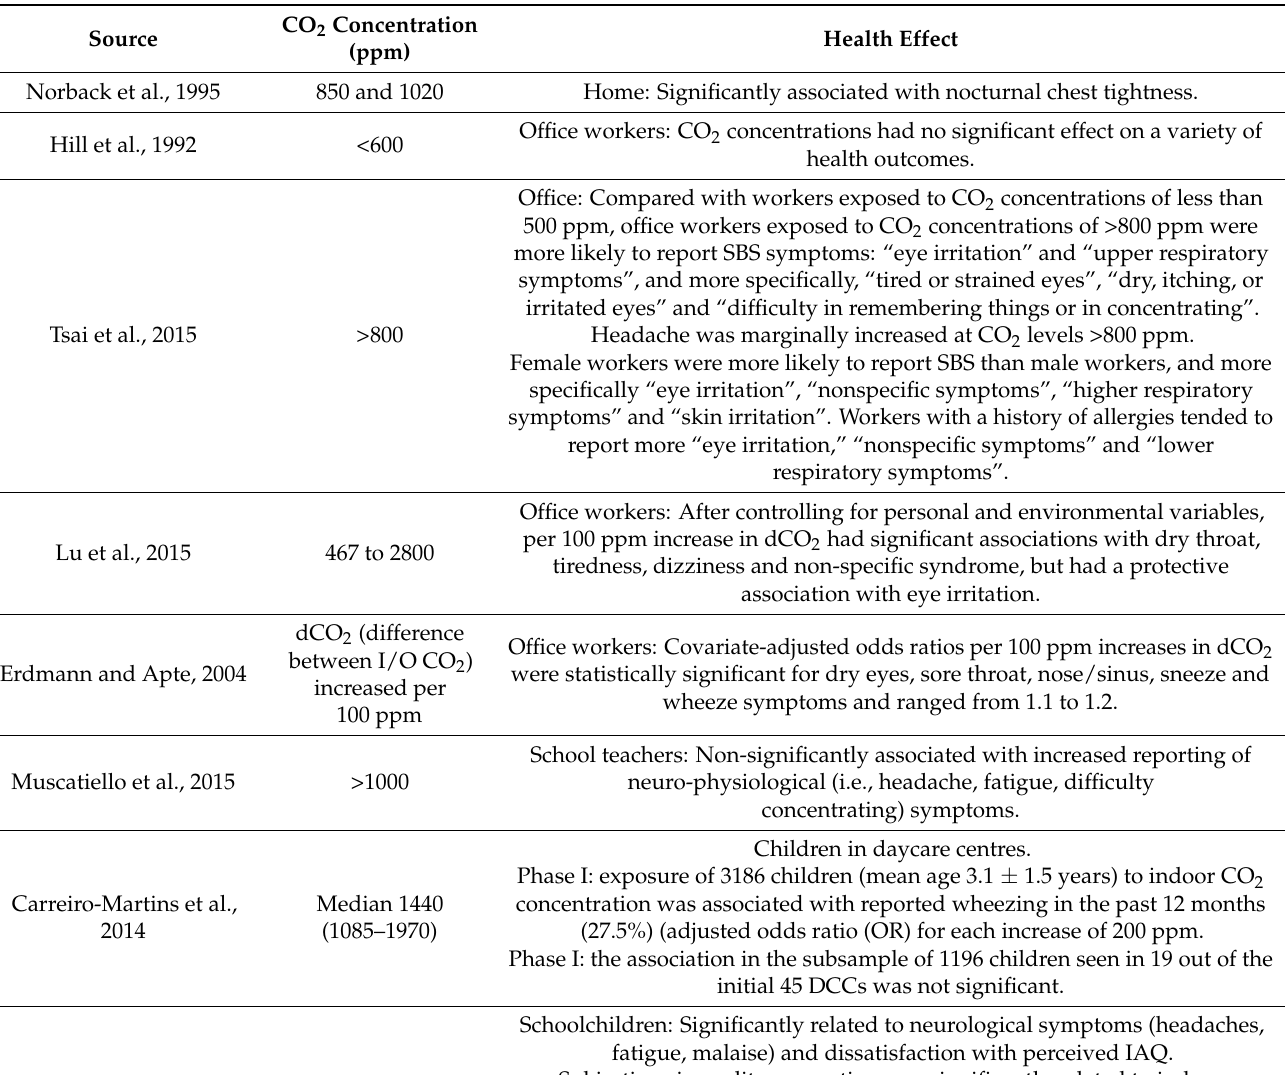
Table A4. A summary of primary research associating CO 2 with neurological symptoms and irritation of the upper airway